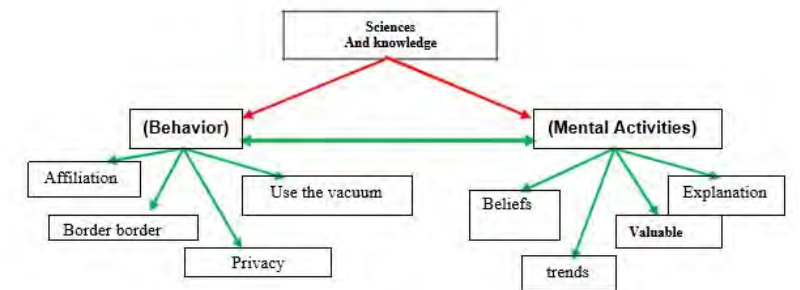
Figure 1. The relationship between mental and behavioralactivities and their impact on understanding and dealing with the